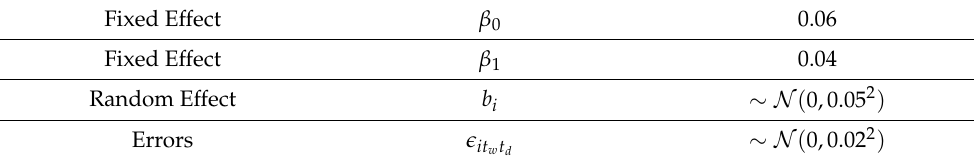
Table 2. Choices for fixed effects, random effect, and errors in the simulation